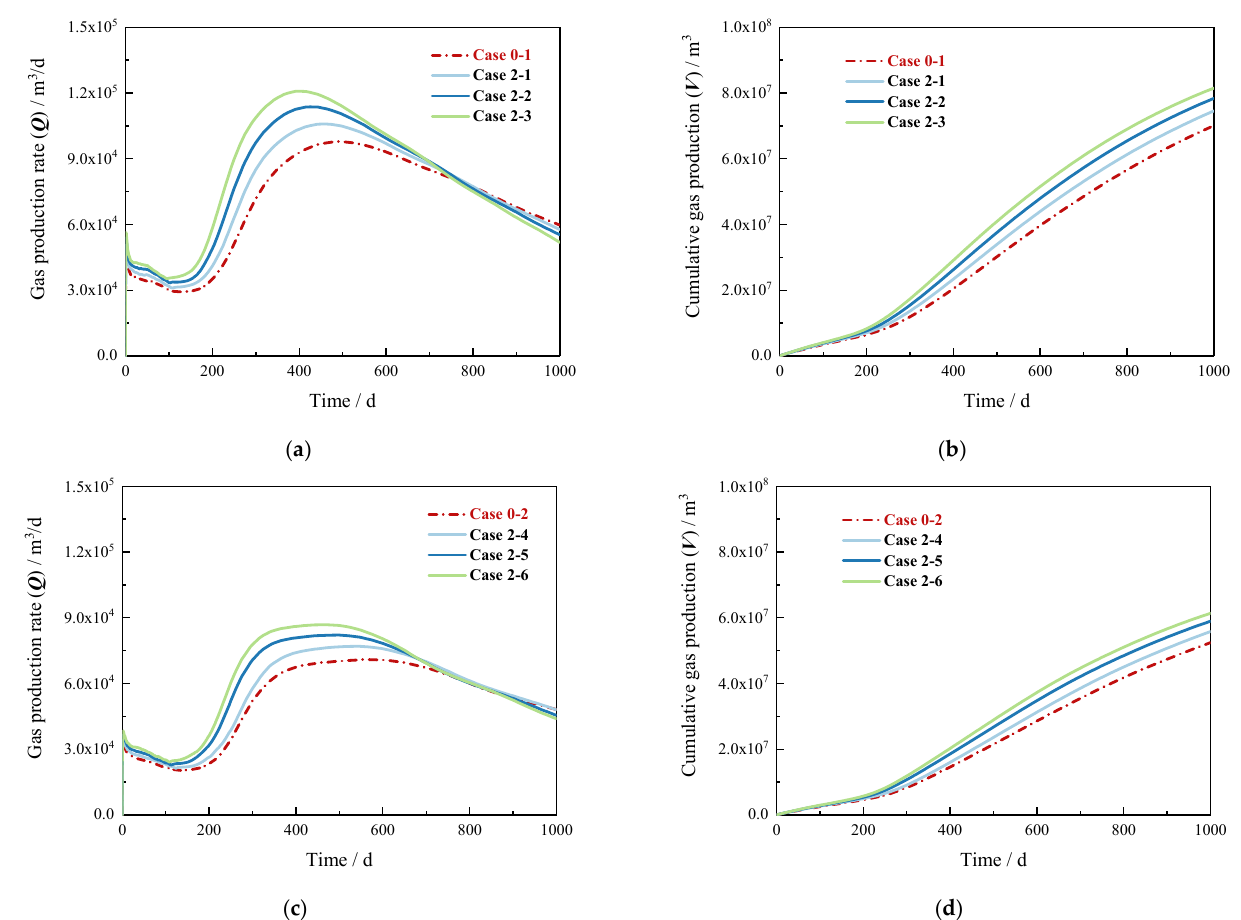
Figure 8. Gas production characteristics for the inner wall heating: ( a ) gas production rate (1 MPa); ( b ) cumulative gas production (1 MPa); ( c ) gas production rate (4 MPa); and ( d ) cumulative gas production (4 MPa).